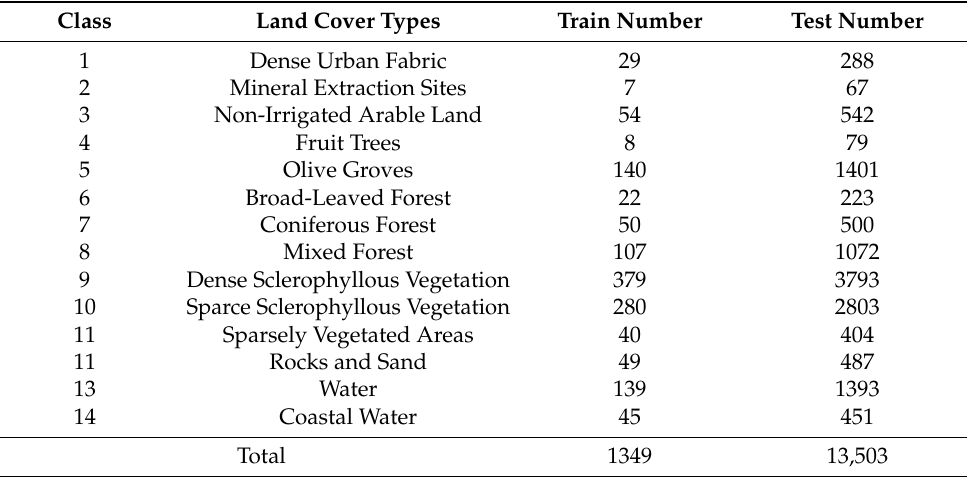
Table 1. Land cover classes with samples number for the HL dataset.